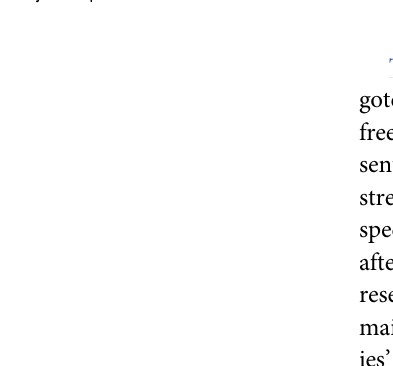
Table 5 shows the free and total amount of cholesterol and ergosterol analysis in epimasti- gotes submitted to lipid stress. According to our results, total cholesterol mass is higher than free cholesterol. Before and after the first 24h of starvation in dFCS, the saponified samples pre- sented masses of 187 and 144 μ g of cholesterol, respectively. When we compare the same lipid stress times in non-saponified samples, the amount of free cholesterol was 27 and 23 μ g, re- spectively, which represents a ratio of 6:1 of total to free cholesterol. The proportion falls to 2:1 after 48h and 72h of lipid starvation. Together, these results reveal that cholesteryl esters from reservosomes and/or lipid bodies probably begin to produce free cholesterol when parasites are maintained in medium with dFCS. Since we did not observe significant variation in lipid bod- ies ’ number or area by electron microscopy, we conclude that most of sterol stocks that were Table 5. Free and total (after saponification) cholesterol and ergosterol contents in lipid starved T . cruzi epimastigotes, kept in LIT medium supple- mented with 10% dFCS for 0, 24, 48 and 72h. Sample in dFCS